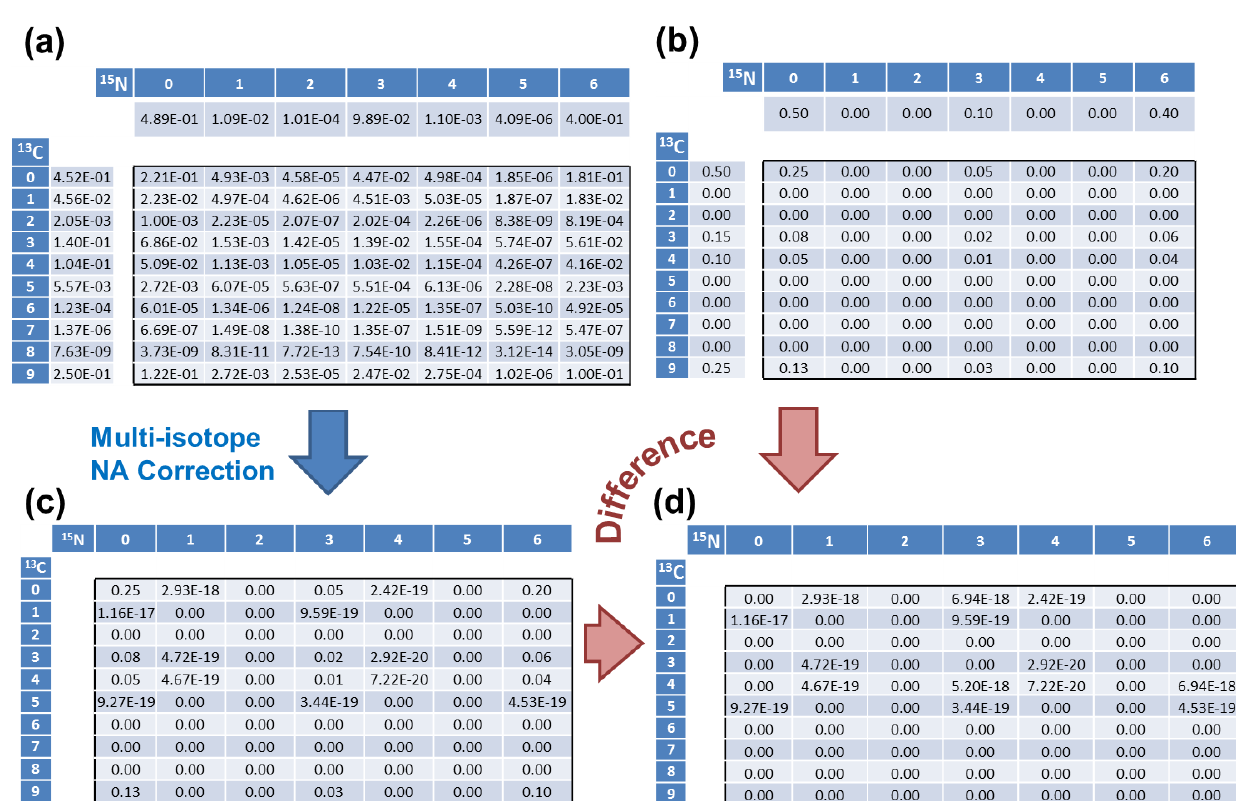
Figure 3. Validation of the multi-isotope natural abundance correction algorithm. ( a ) The matrix outlined by the black lines represents isotopologue intensities with 13 C and 15 N isotopes from both a labeling source and natural abundance. It is calculated from the vector outer product of two single isotope labeled vectors of isotopologue intensities. These single-labeled vectors represent the addition of 13 C/ 15 N natural abundance to the corresponding single-labeled vectors in ( b ). Each vector and matrix of intensities is normalized to a sum of 1. ( b ) The matrix outlined by the black lines represents isotopologue intensities with 13 C and 15 N isotopes from only a labeling source. It is calculated from the vector outer product of two single isotope labeled vectors of isotopologue intensities. ( c ) This matrix is the result of just one iteration of the multi-isotope natural abundance correction algorithm implemented in the Python programming language. ( d ) This matrix is the absolute difference between the matrices in ( b ) and ( c ). No element is larger than 10 − 17